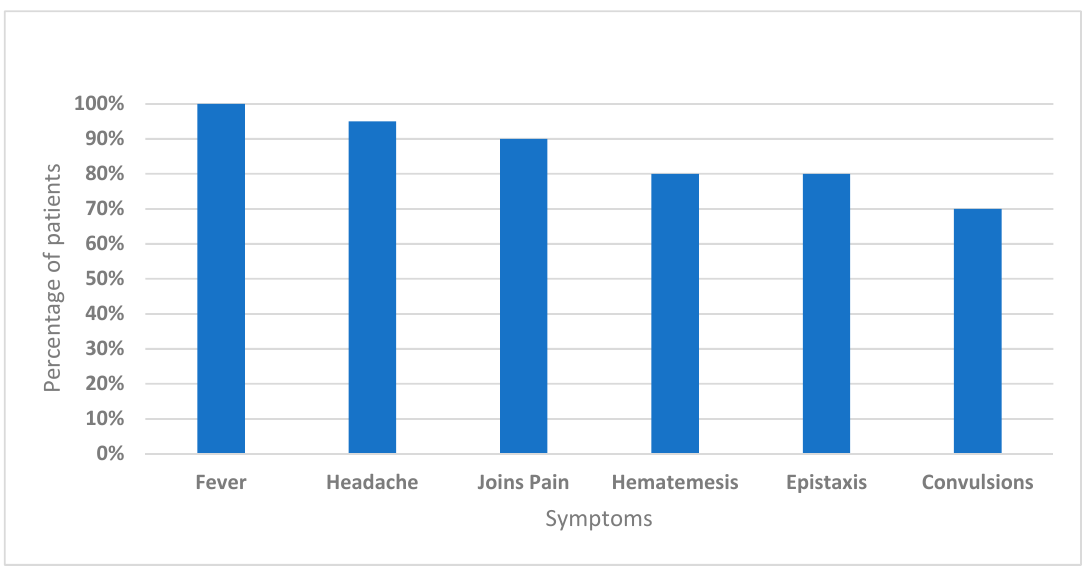
Figure 4. The clinical presentation of Crimean-Congo hemorrhagic fever (CCHF) cases. Twelve deaths were reported in 2010, representing a 31% case fatality rate (CFR), while a single death was reported in 2011 (CRF 4%). The overall male to female ratio of patients was 2:1, and the average age of patients was 28 years old. Cases presented with fever and hemorrhage, and no other clinical symptoms were recorded.